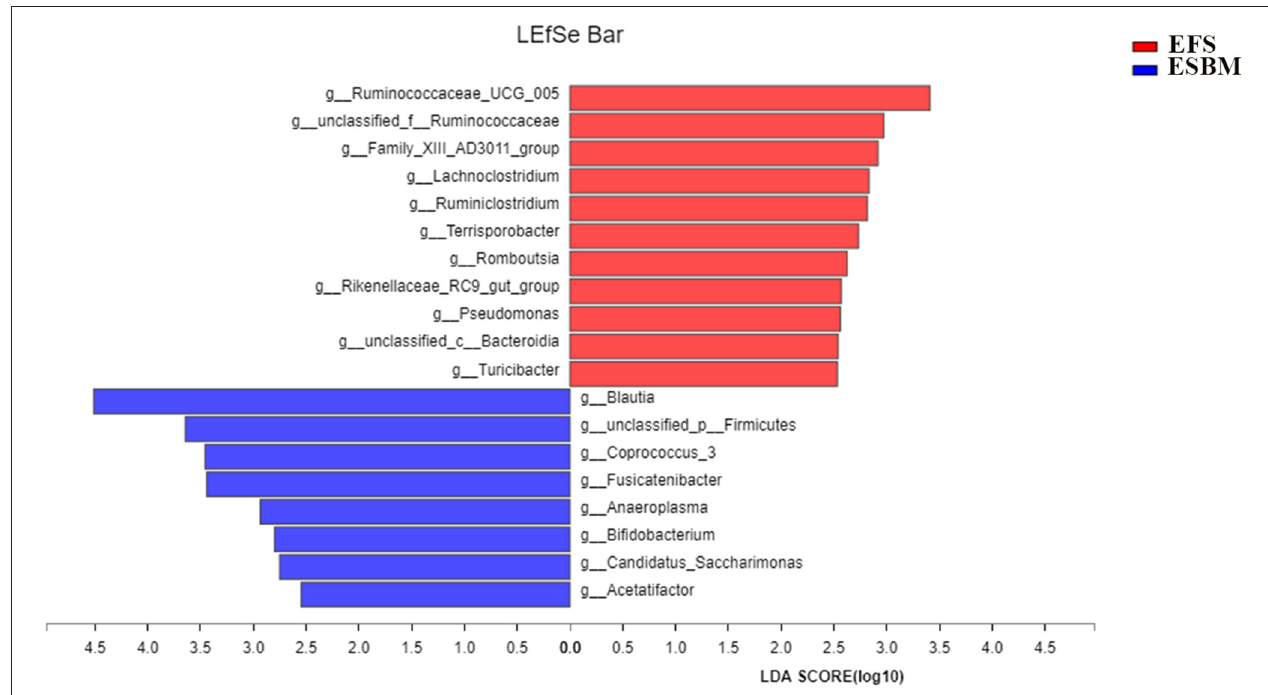
FIGURE 3 | Identification of the most differentially abundant genera in cecum of the two dietary treatments. The plot was generated from Linear Discriminant Analysis Effect Size (LEfSe) analysis with CSS-normalized OTU table and displays taxa with LDA scores above 2.5 and P -values below 0.05. Genera enriched in the samples with EFS diet are indicated with red bars, and genera enriched in the samples with ESBM diet are indicated with blue bars. The individual minipig was regarded as the experimental unit, n = 5 for EFS, n = 5 for ESBM. EFS, extruded full-fat soybean; ESBM, enzyme-treated soybean meal.